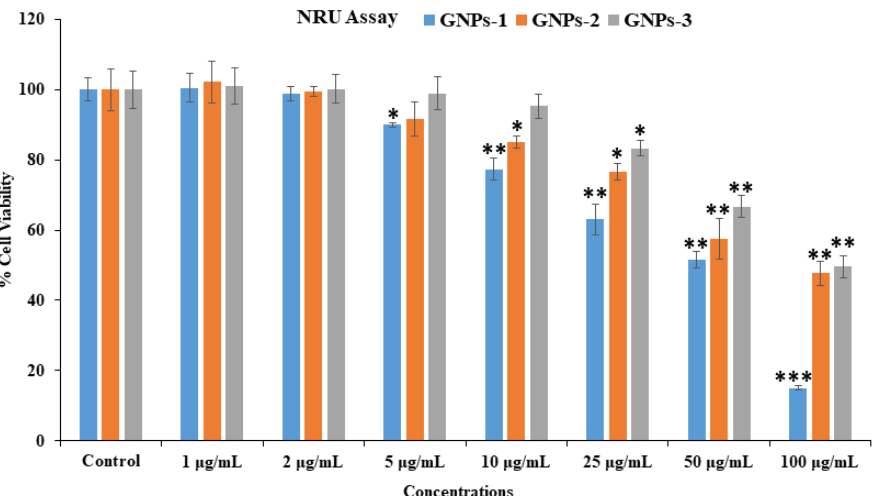
Figure 6. Cytotoxicity assessment by NRU assay in HepG2 cells after exposure to GNPs-1, GNPs-2, and GNPs-3 at different concentrations for 24 h. The values are mean ± SE of three independent experiments. * p < 0.05, ** p < 0.01, *** p < 0.001 vs. control. Table 1. Comparative anticancer activity of gold NPs against liver cells by MTT assay.